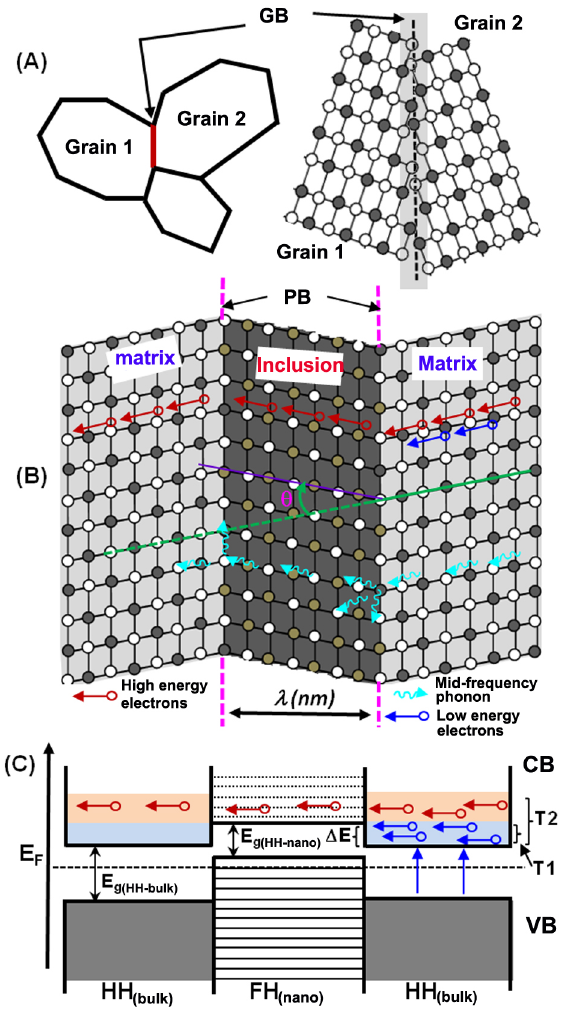
Figure 15. Schematic illustration of examples of atomic scale structural engineering leading to large enhancements of the thermoelectric performance of bulk half-Heusler matrices. ( A ) Incoherent interface at grain boundaries (BG); ( B ) coherent phase boundaries (PB) between matrix and inclusion phases with similar structure, which allow close crystallographic registry between both regions; ( C ) nanometer scale heterojunction between bulk HH matrix and nanometer scale FH inclusion highlighting the proposed low energy electron filtering mechanism. The conduction band offset, Δ E, is a critical parameter for a simultaneous large increase in both the Seebeck coefficient and the electrical conductivity through filtering of low energy electrons. Cyan and orange colors represent distributions of low and high energy electrons at temperatures T1 and T2 (T2 > T1). Reproduced with permission from Reference [80]. Copyright 2011, American Chemical